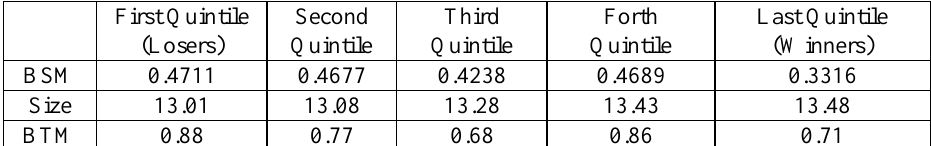
Table (2): The Characteristics of Momentum Portfolios